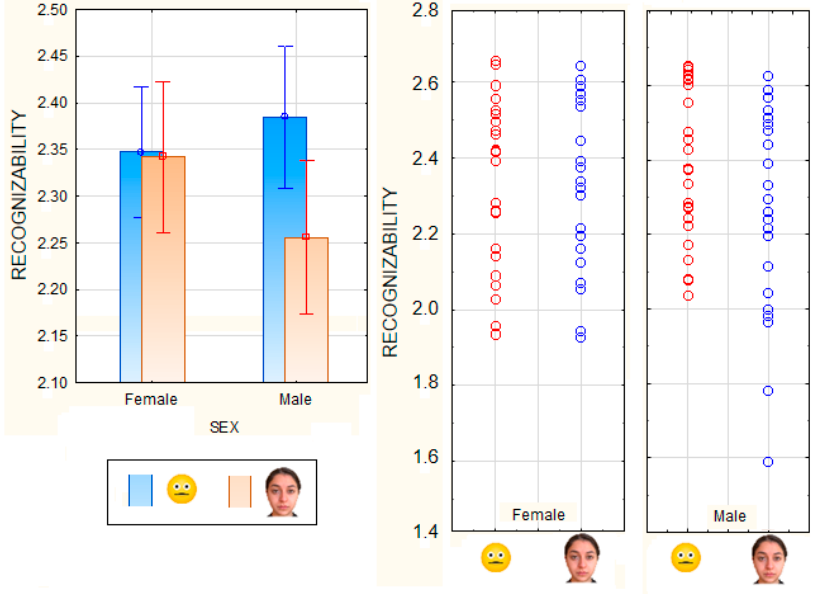
Figure 4. Mean scores and distribution of individual performance as a function of stimulus type and sex of viewers. On the y-axis are visible recognizability scores, while on the x-axis are subjects’ sex and